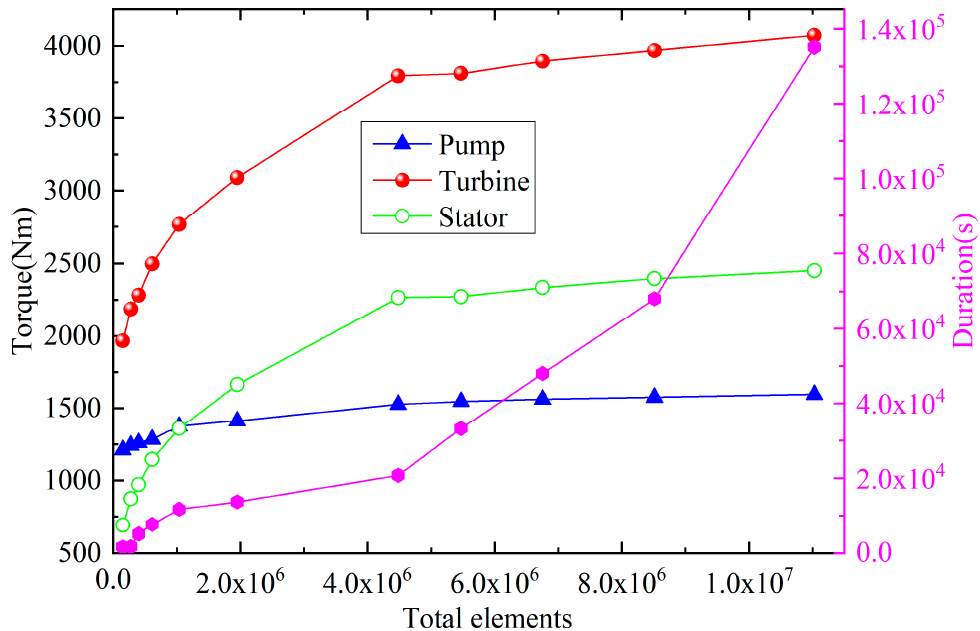
Figure 5. Predicted torque results under variant element density (speed ratio ( SR ) = 0).